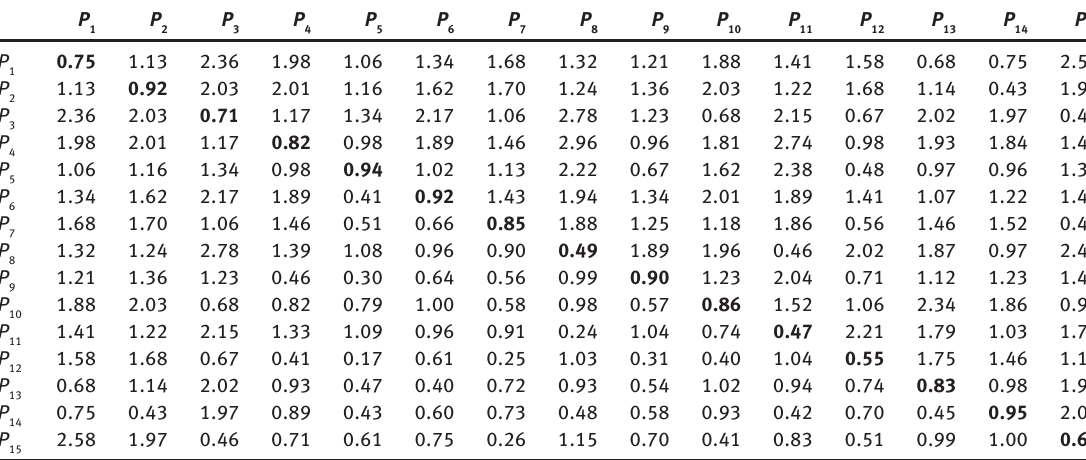
Table 8: Overall Values of Individual Knowledge Competence and Knowledge